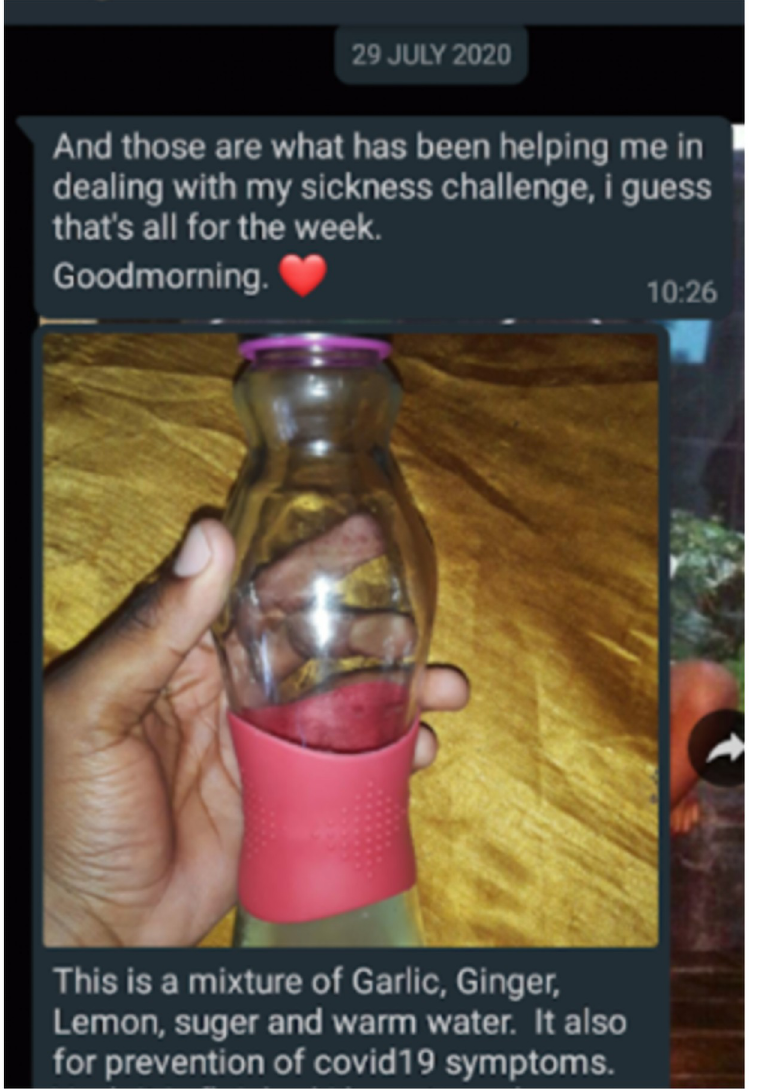
Fig 3. Lungelo’s W4 digital diary entry illustrating traditional